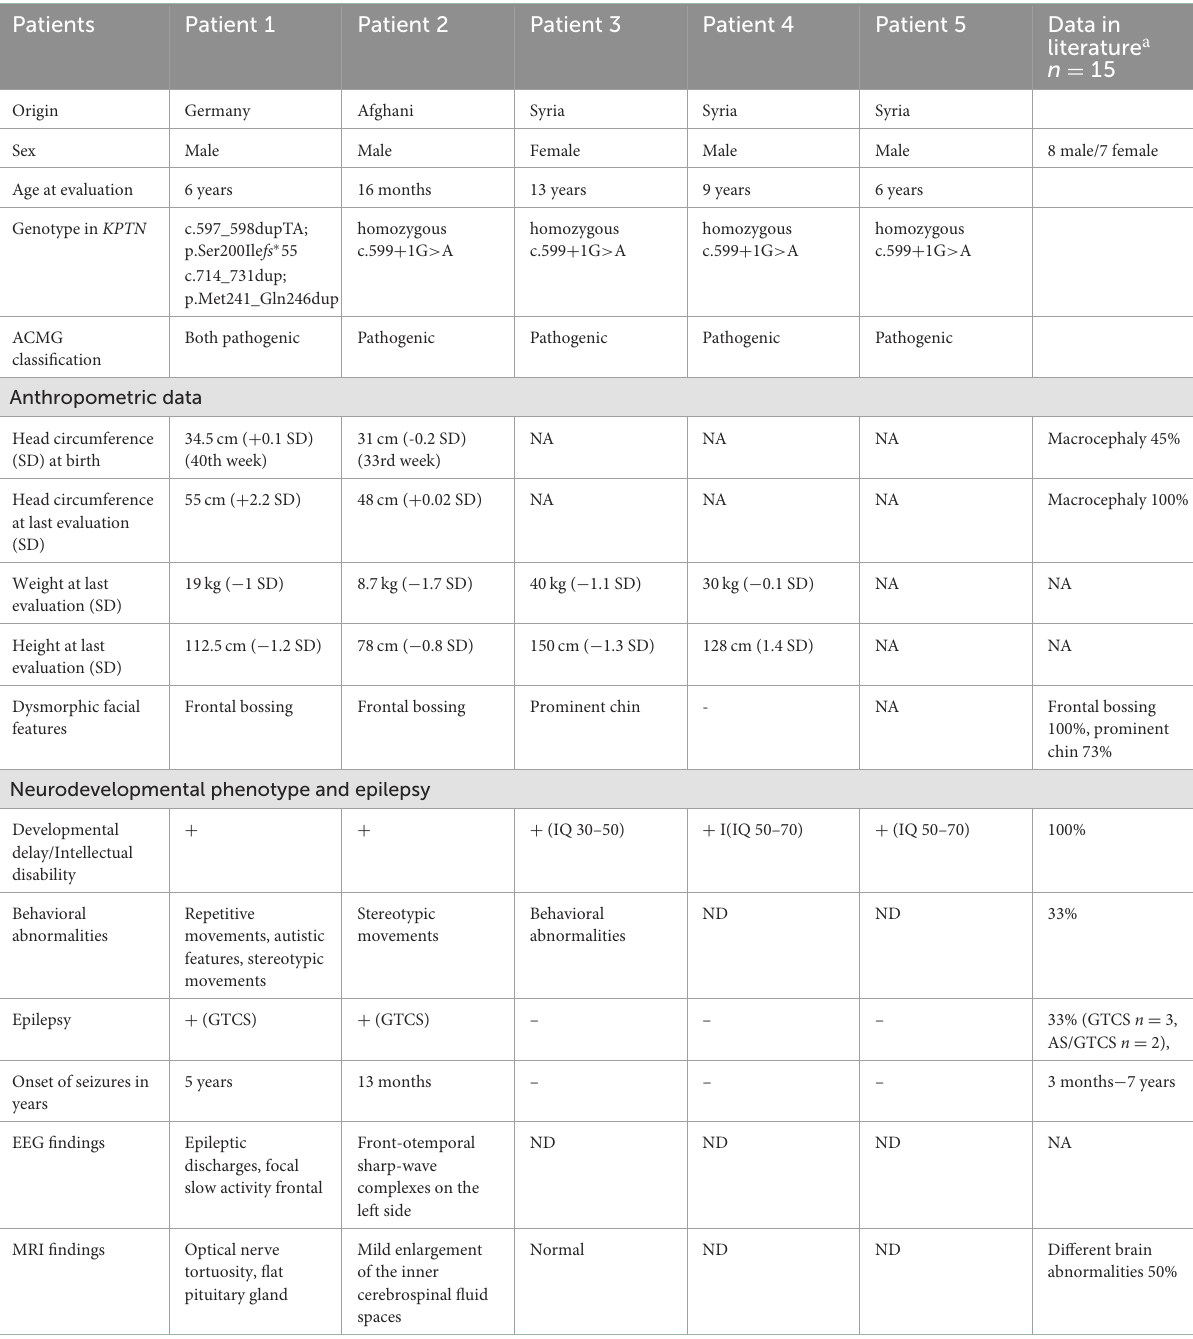
TABLE 1 Comparison of clinical manifestations of KPTN gene-related syndrome in five novel patients with previously reported patients.